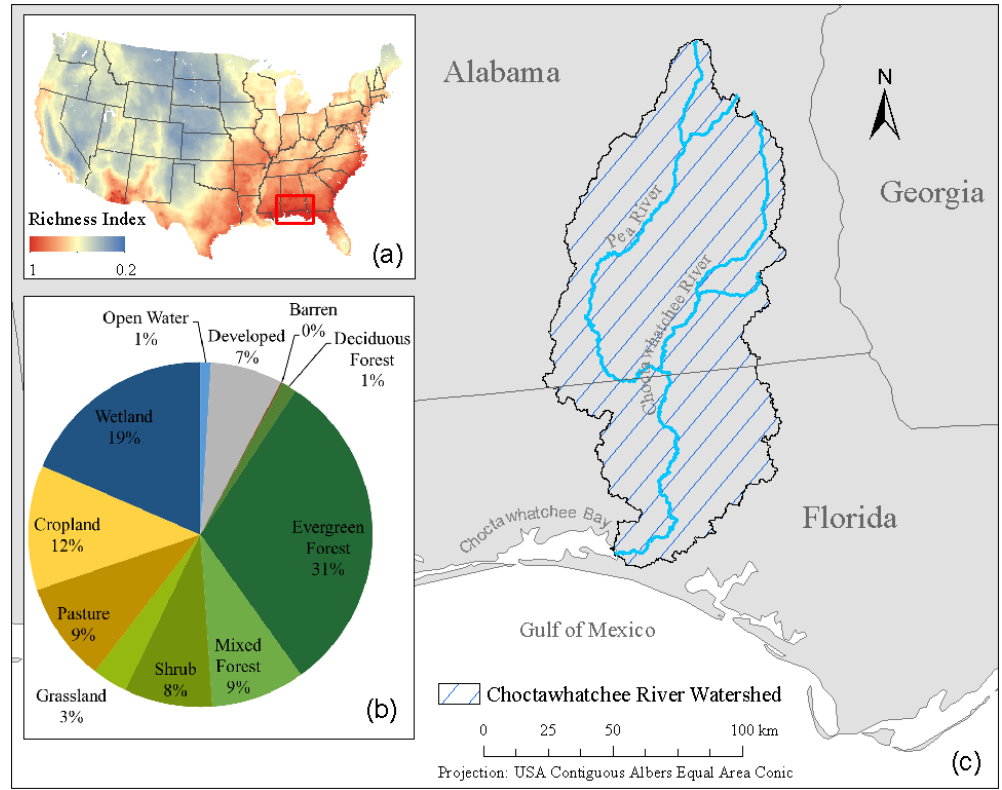
Figure 1. Location of the Choctawhatchee River Watershed. ( a ) The species richness index of the United States is shown as are where the watershed is in the United States, higher richness index values are shown as red and lower values in blue. ( b ) A pie chart of the proportion of each LULC. ( c ) The full extent of the watershed and the locations of the Choctawhatchee and Pea Rivers. Table 1. The details of the spatial data used in the